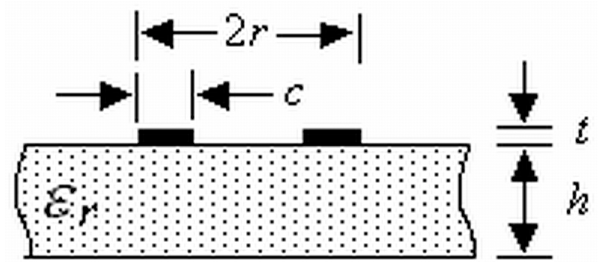
Figure 3. Cross section of a basic ORR cell.